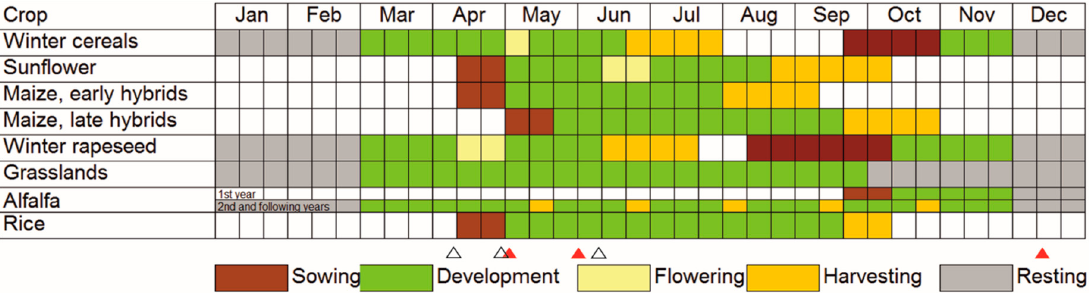
Figure 3. Crop calendar of the main crops and crop types in the study areas. The approximate time of the Sentinel-2 images used for the multi-date classification (see Section 2.2) are indicated by open triangles (Knezha) and red triangles (Belozem).